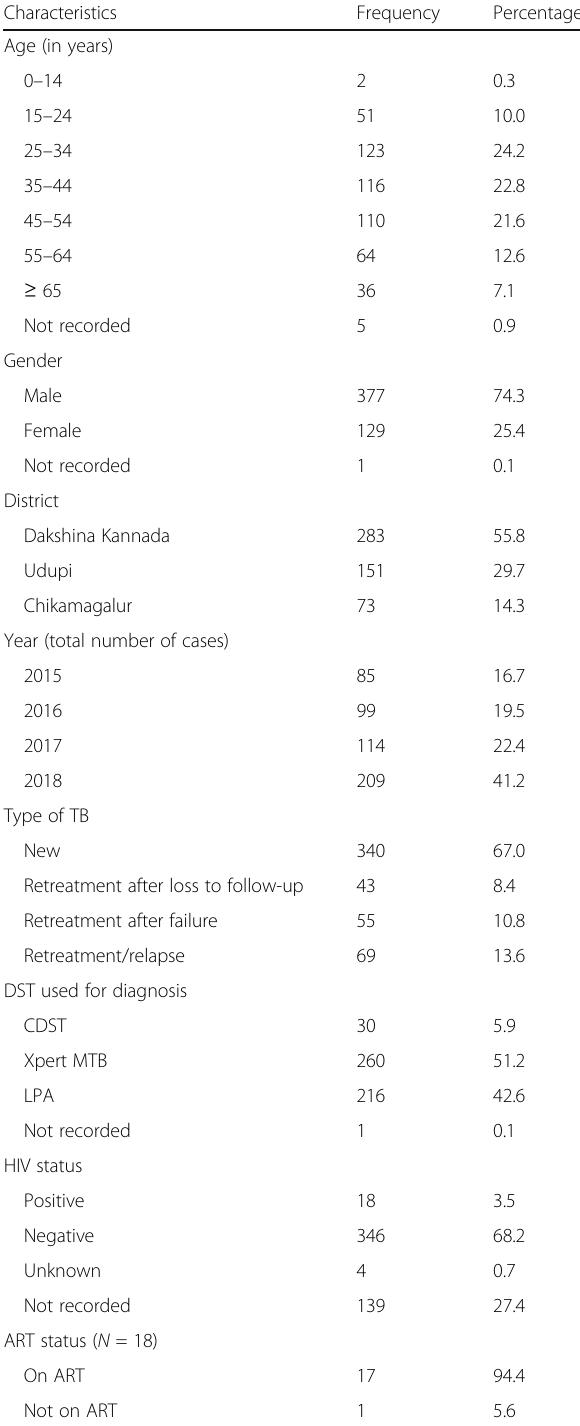
Table 1 Socio-demographic and clinical characteristics of DR-TB patients initiated on treatment under the national TB program in three selected districts of Karnataka during 2015 to 2018, N = 507